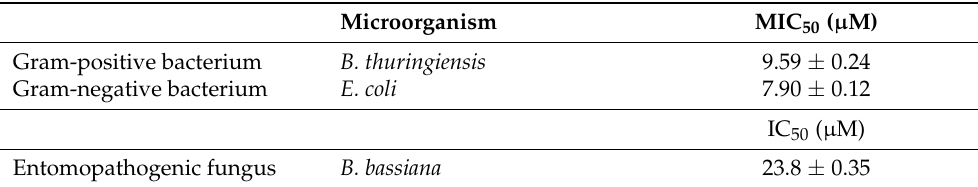
Table 1. Antimicrobial activity of recombinant Apis mellifera apidermin 2 (AmAPD 2) against bacteria and